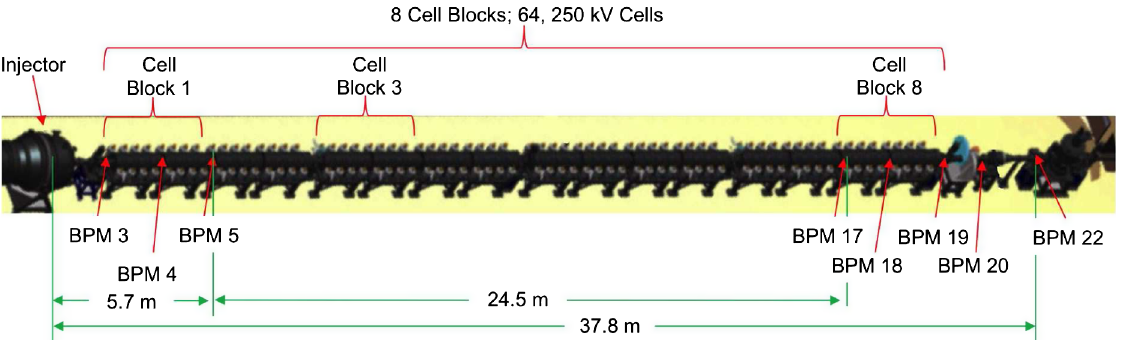
FIG. 1. Model of the DARHT Axis-I accelerator, consisting of the 4 MV injector, 64 induction cells and a BPM located after every four